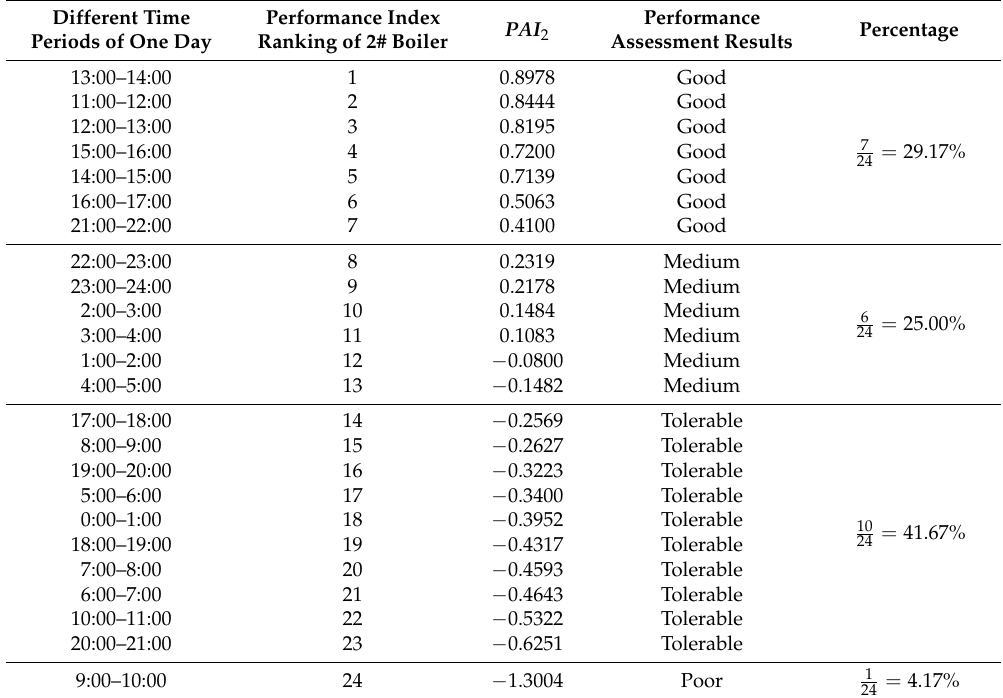
Table 7. The results and ranking of performance assessment index PAI 2 . (2# Boiler combustion control process). Different Time Periods of One Day